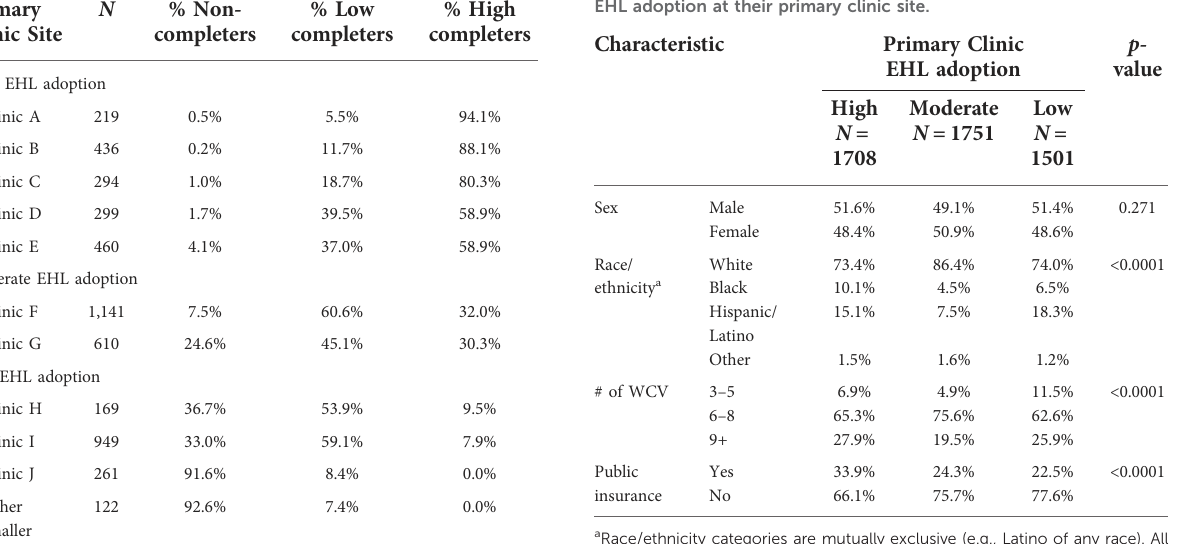
TABLE 3 Comparison of selected characteristics of patients by level of EHL adoption at their primary clinic site.